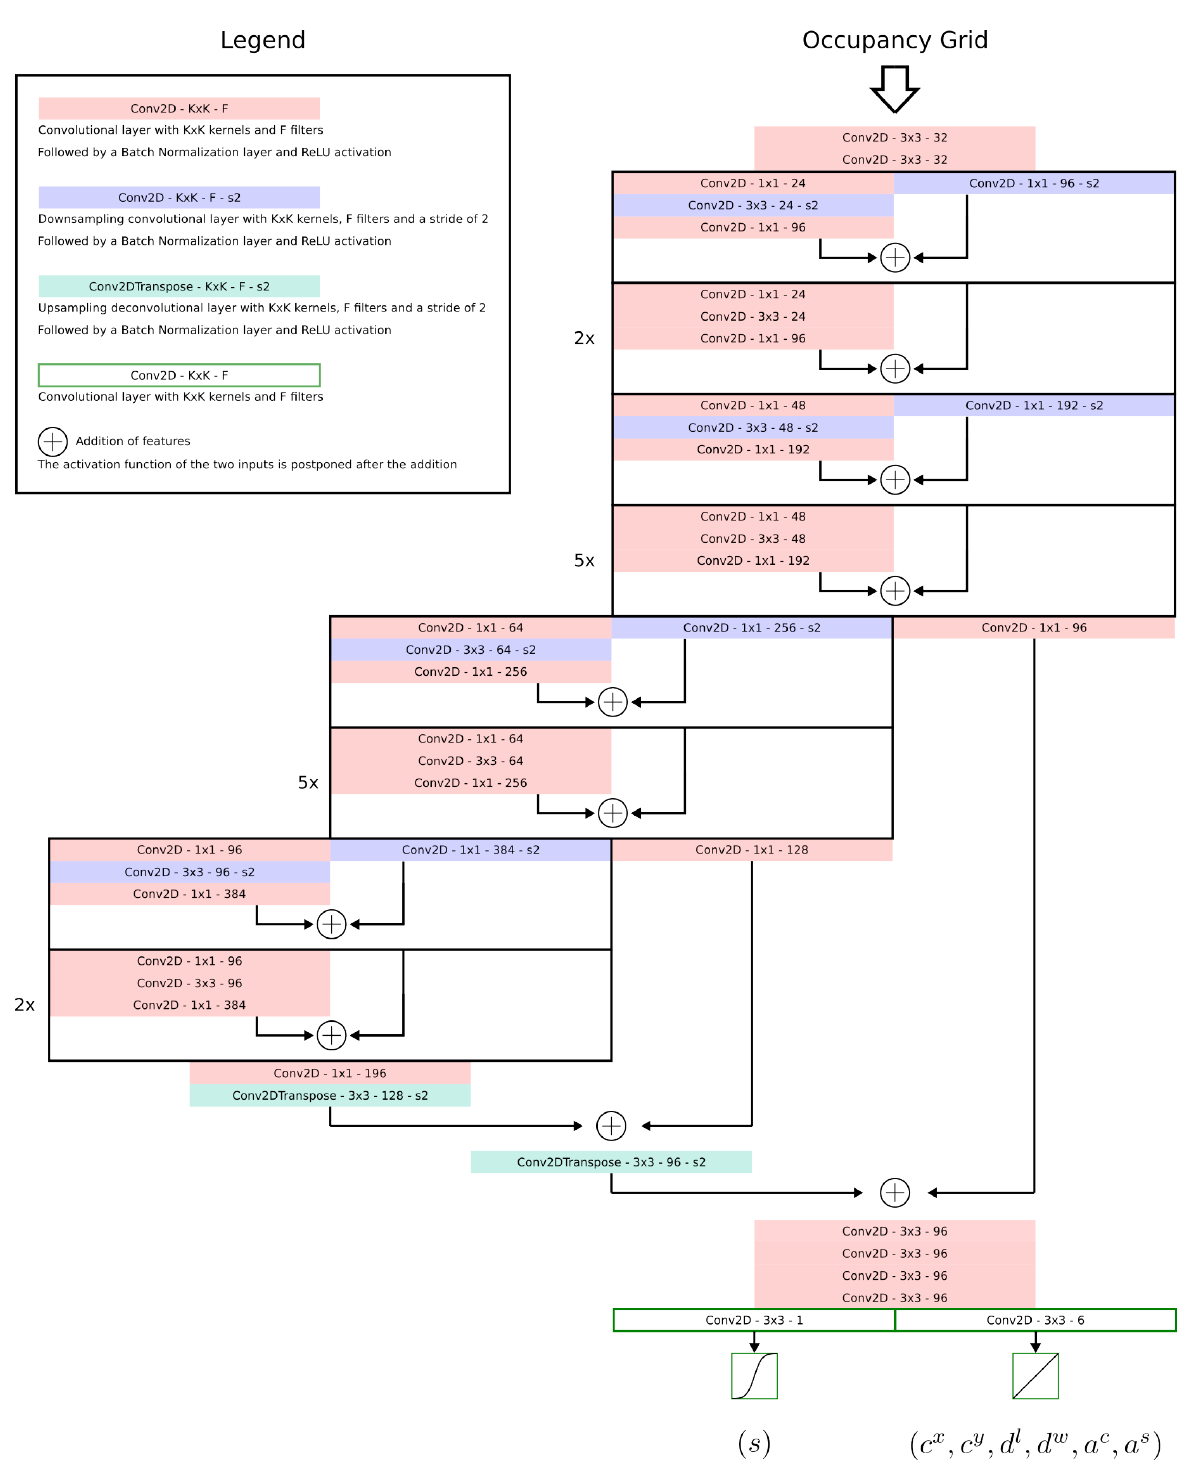
Figure A4. Architecture of GRID-PIXOR containing 2,132,091 trainable